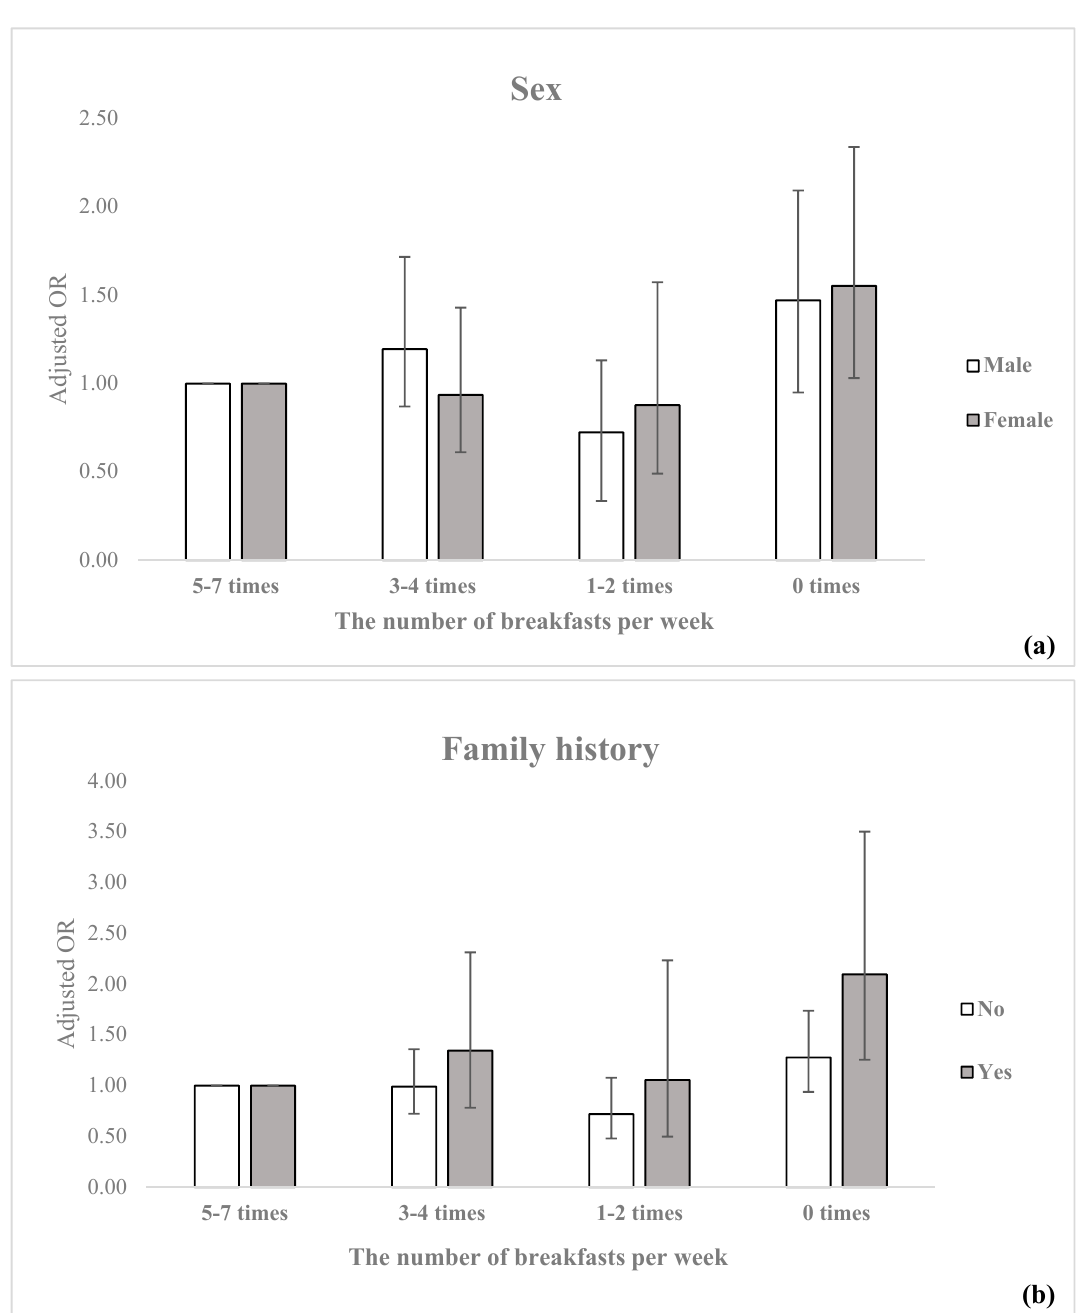
Figure 1. Subgroup analysis of the association between ASCVD high-risk and breakfast frequency stratified by ( a ) sex and (b) family history. Adjusted OR, all covariates were adjusted. ASCVD risk: 10-year ASCVD risk was measured using a pooled cohort equation. 10-year risk < 7.5%: normal group, ≥ 7.5%: high-risk group. ( b ) Family history: related to CVD such as stroke, myocardial infarction, angina. ASCVD: atherosclerotic cardiovascular disease, adjusted OR: adjusted odds ratio.